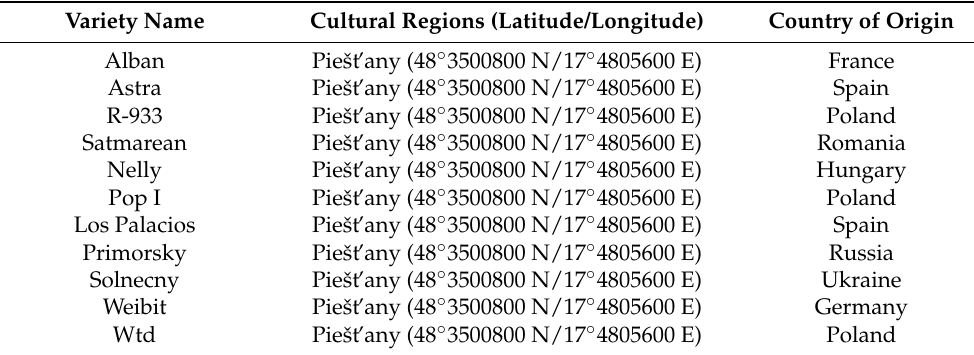
Table 6. The country of origin and the cultural regions of the investigated white lupin varieties. Variety